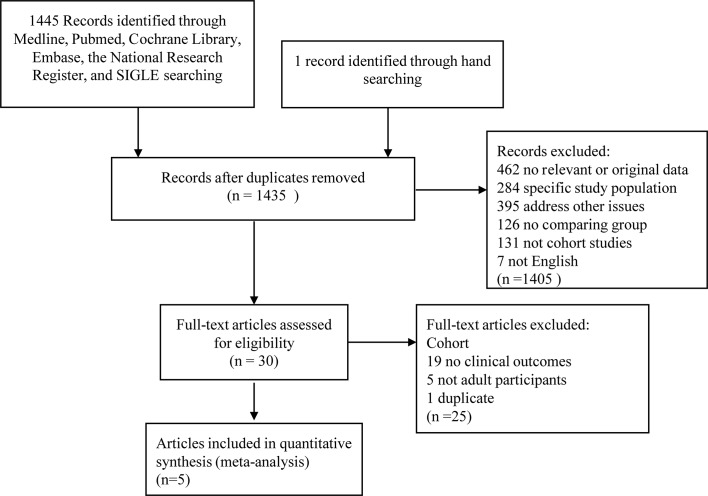
Flow chart on the articles selection process.